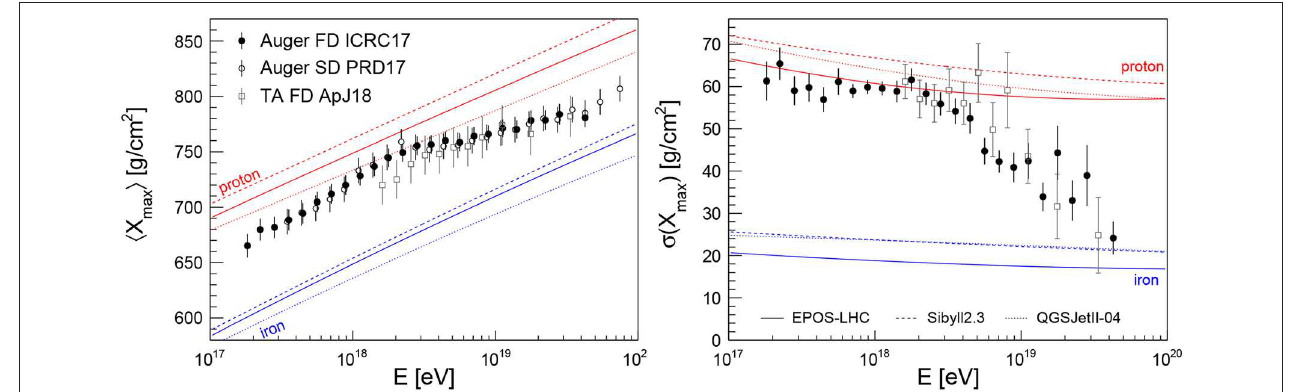
FIGURE 4 | Measurements (Abbasi et al., 2018d; Bellido, 2018) of the mean ( Left ) and standard deviation ( Right ) of the distribution of shower maximum as a function of energy. Data points from the Pierre Auger Observatory are shown as published since they have been corrected for detector effects. Data from the Telescope Array have been approximately corrected for detector effects by shifting the mean by +5 g/cm 2 (Yushkov, 2018) and by subtracting an X max -resolution of 15 g/cm 2 (Abbasi et al., 2018d) in quadrature. Furthermore, the TA data points were shifted down by 10.4% in energy to match the energy scale of the Pierre Auger Observatory (Ivanov, 2018 ) (see also De Souza, 2018 for a discussion of the good overall compatibility of the X max measurements from the Pierre Auger Observatory and the Telescope Array). All error bars denote the quadratic sum of the quoted statistical and systematic uncertainties. The energy evolution of the mean and standard deviation of X max obtained from simulations (Bergmann et al., 2007) of proton- and iron-initiated air showers are shown as red and blue lines respectively. The line styles indicate the different hadronic interaction models (Ostapchenko, 2011; Pierog et al., 2015; Riehn et al., 2016) used in the simulation. M. Unger for this review.